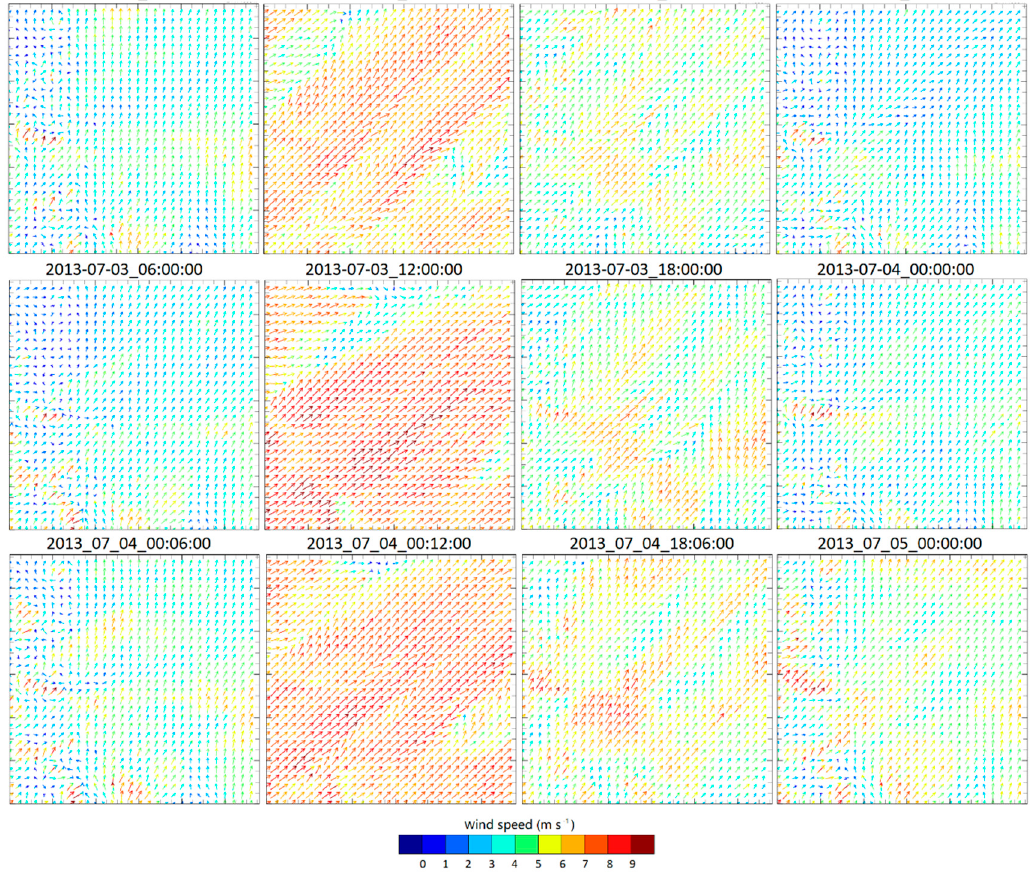
Figure A1. Simulated d03 (Figure 1) wind vectors every six hours (2–5 July 2013